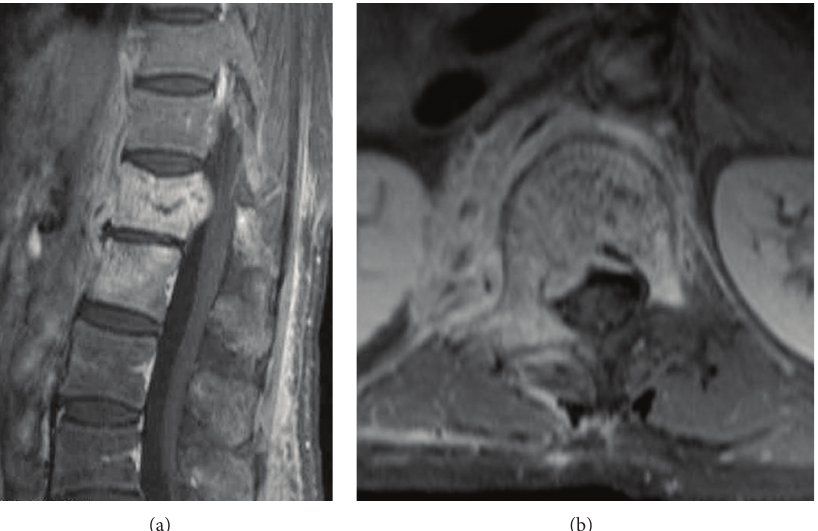
Figure 1: Enhanced T1-weighted magnetic resonance imaging showing vertebral osteomyelitis which involved the L1 and L2 vertebral bodies. (a) Sagittal view. (b) Axial